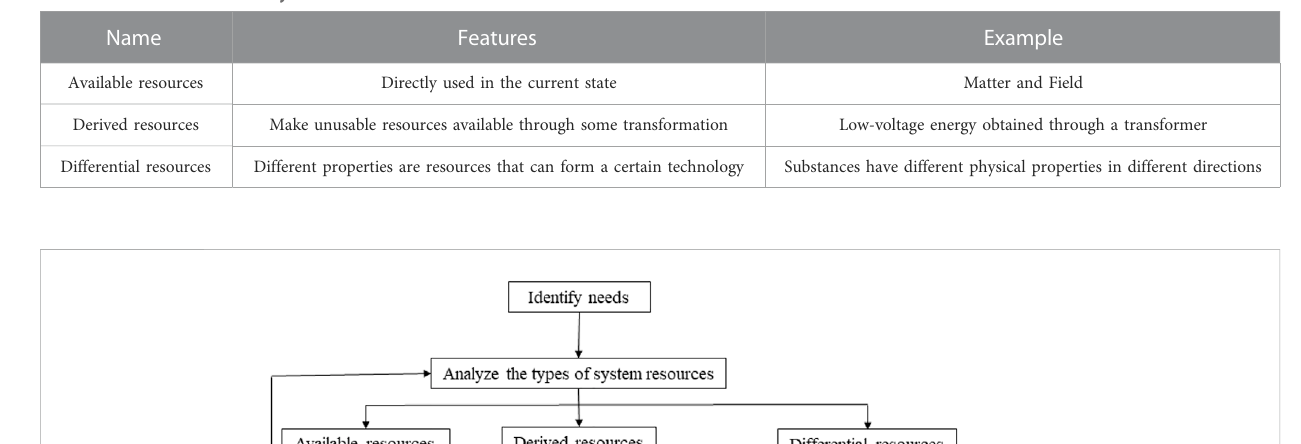
TABLE 1 Classi fi cation of the system resources.